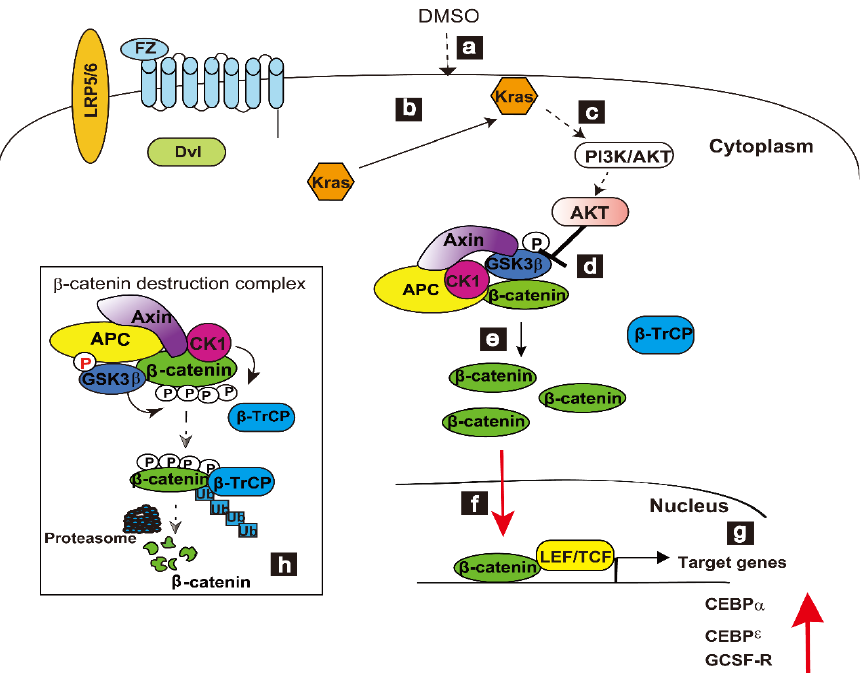
Figure 3. Association of WT-Kras with Wnt/ β -catenin signaling networks in the DMSO-induced differentiation of HL-60 cells. DMSO triggers Kras activation through the recruitment of Kras to the plasma membrane (a,b). AKT phosphorylates GSK3β and inactivates GSK3β (c,d ). Accumulated unphosphorylated β -catenin in the cytoplasm translocates to the nucleus (e,f), where it binds to